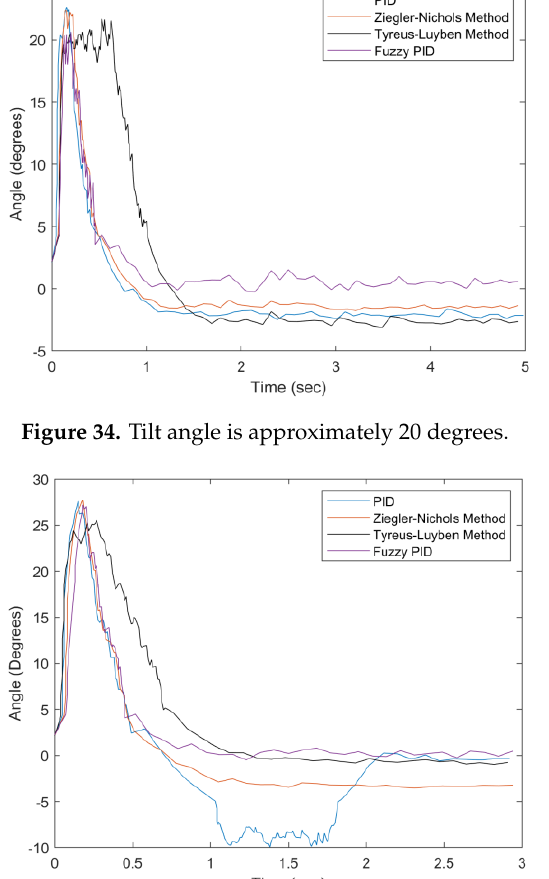
Table 9. Comparison of Experiment II.